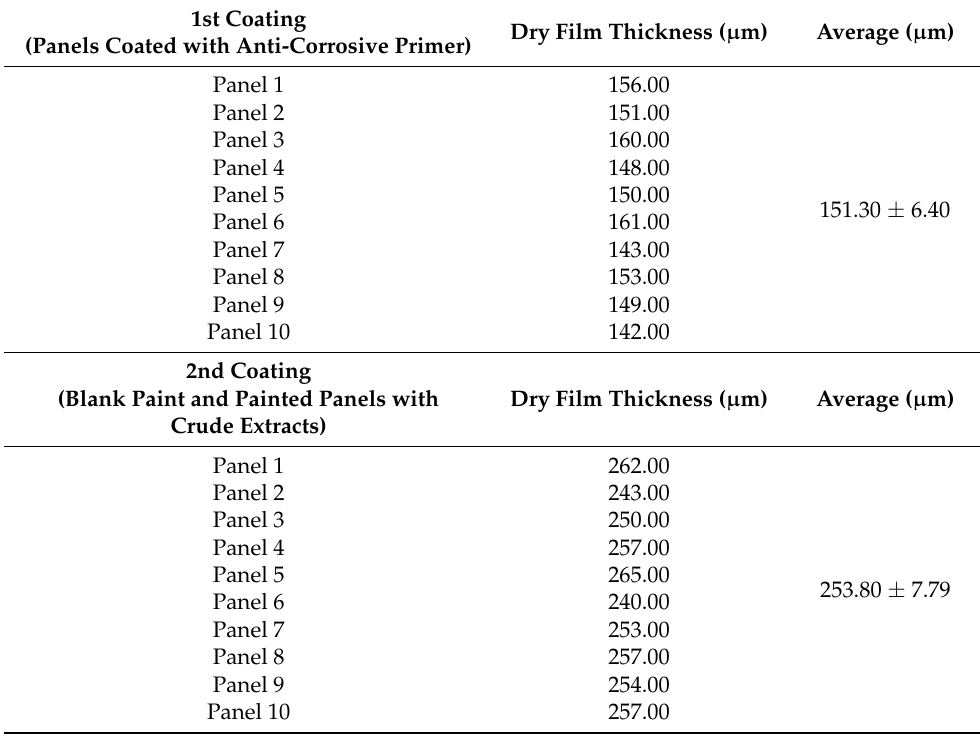
Table 2. Average DFT of the panels after coating with primer (1 st coating) and painted panels with crude extracts (2nd